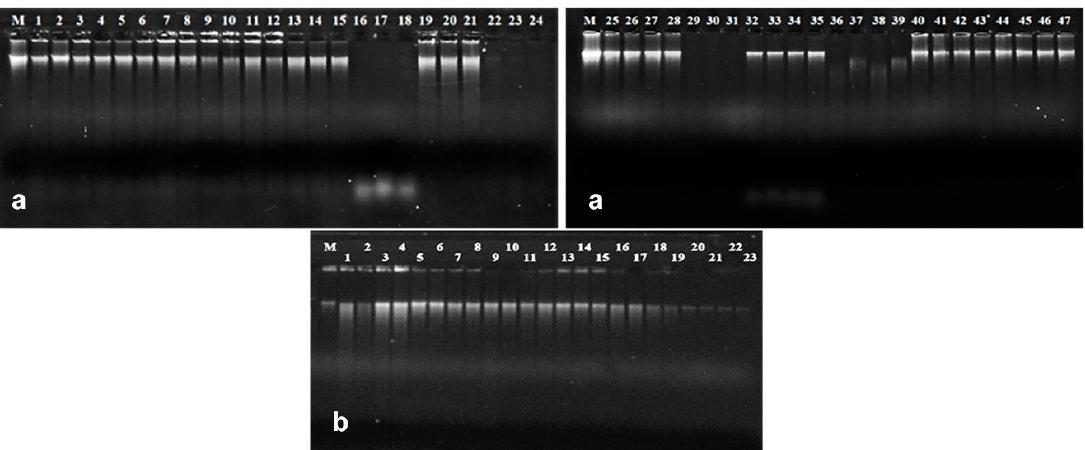
Figure 1. Genomic DNA extracted from opium poppy seeds ( a ) by: Dellaporta et al. [24] (lanes 1–6, where 1–3 homogenization with liquid nitrogen, 4–6 homogenization without liquid nitrogen), Dellaporta et al. [24] with CTAB (lanes 7–12, where 7–9 homogenization with liquid nitrogen, 10–12 homogenization without liquid nitrogen), Bayer BioScience N.V. [25] (lanes 13–15), Murray, DNeasy ® Plant Maxi Kit (lanes 25–28), Plant DNAzol ® Reagent (lanes 29–31), QIAamp DNA Stool Mini Kit (lanes 32–35), PowerSoil DNA Isolation Kit (lanes 36–39), newly developed protocol (lanes 40–47). Lane M— λ -phage DNA. ( b ) Ground poppy seeds: DNA extracted by: Bayer BioScience N.V. [25] (lanes 1–7, lines 1–4, 0.2 g of seeds with extraction buffer volume for 0.2 g; lanes 5–7, 0.2 g of seed with extraction buffer volume for 0.5 g of seeds), Monsanto Company (26) (lanes 8–11), newly developed protocol (lanes 12–15), DNeasy ® Plant Maxi Kit (lanes 16–19), QIAamp DNA Stool Mini